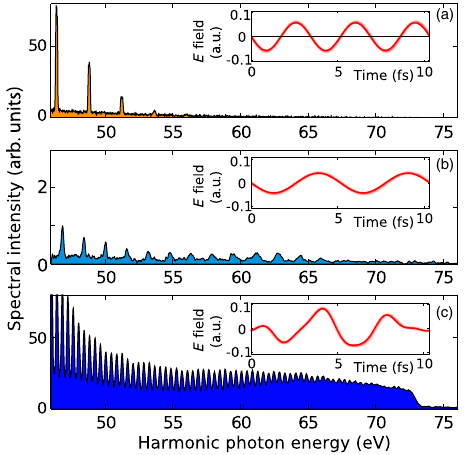
FIG. 6. Experimental HHG spectra generated in argon with different driver waves, shown in the insets. The spectral intensities are given on the same scale and are thus directly comparable — note, however, the different ordinate axis in (b). (a) 1030-nm driver with the same 0.54-mJ pulse energy as the three-color pulses, leading to the onset of saturation in HHG [24]. (b) 1545-nm driver with the full OPA output pulse energy (0.35 mJ). (c) Chosen three-color driver ( ϕ 2 ¼ 1 . 8 π and ϕ ¼ 0 . 3 π ) giving the highest HHG signal between 60 eV CEP and the Al-filter absorption edge. Atomic units